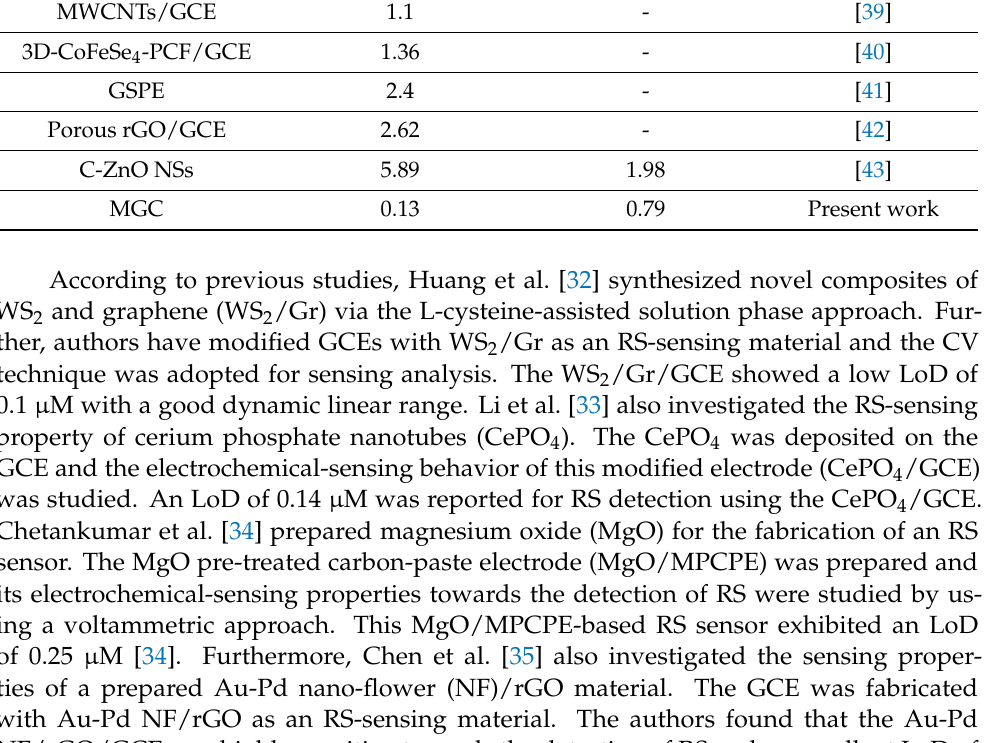
Table 1. Comparison of the sensitivity and LoD of the MGC against published literature [32–43]. Sensing Material